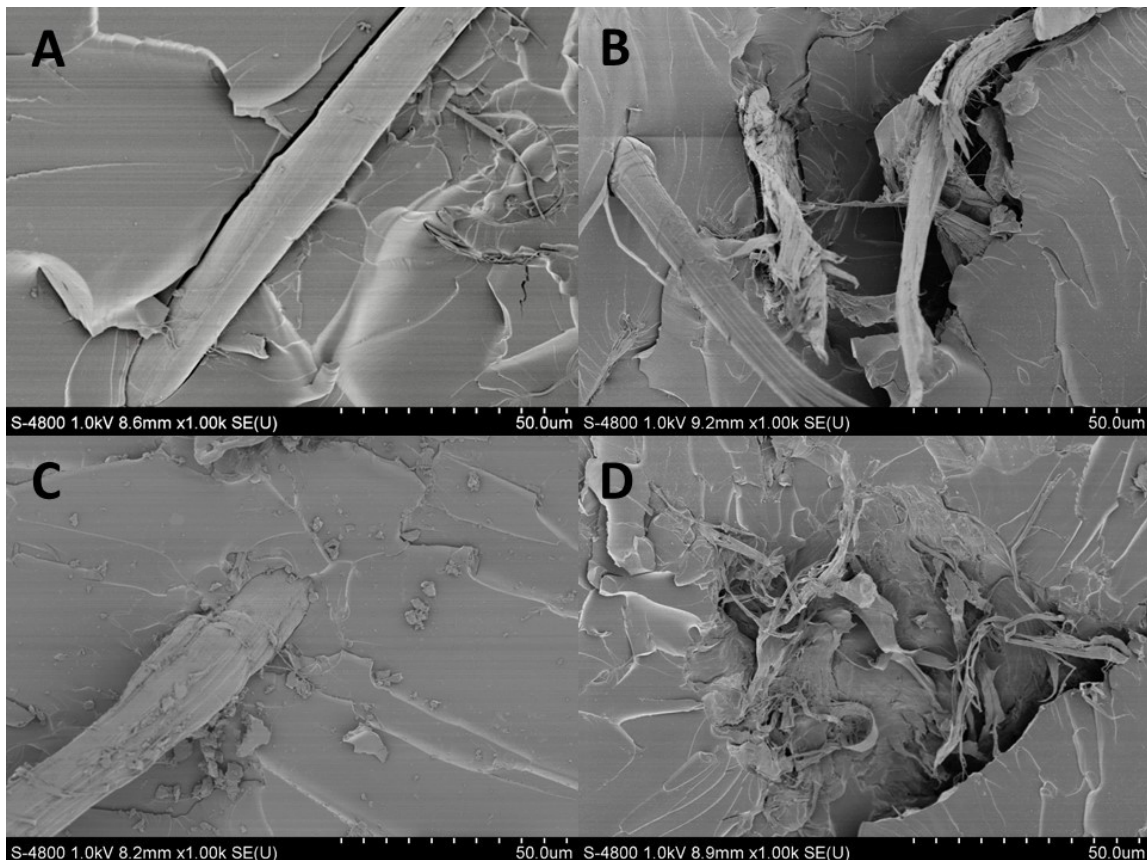
Figure 13: SEM images of fracture surface of fibers/epoxy composites with different mass fractions of AF and GO-AFs; (A) 0.1 wt% AF; (B) 0.7